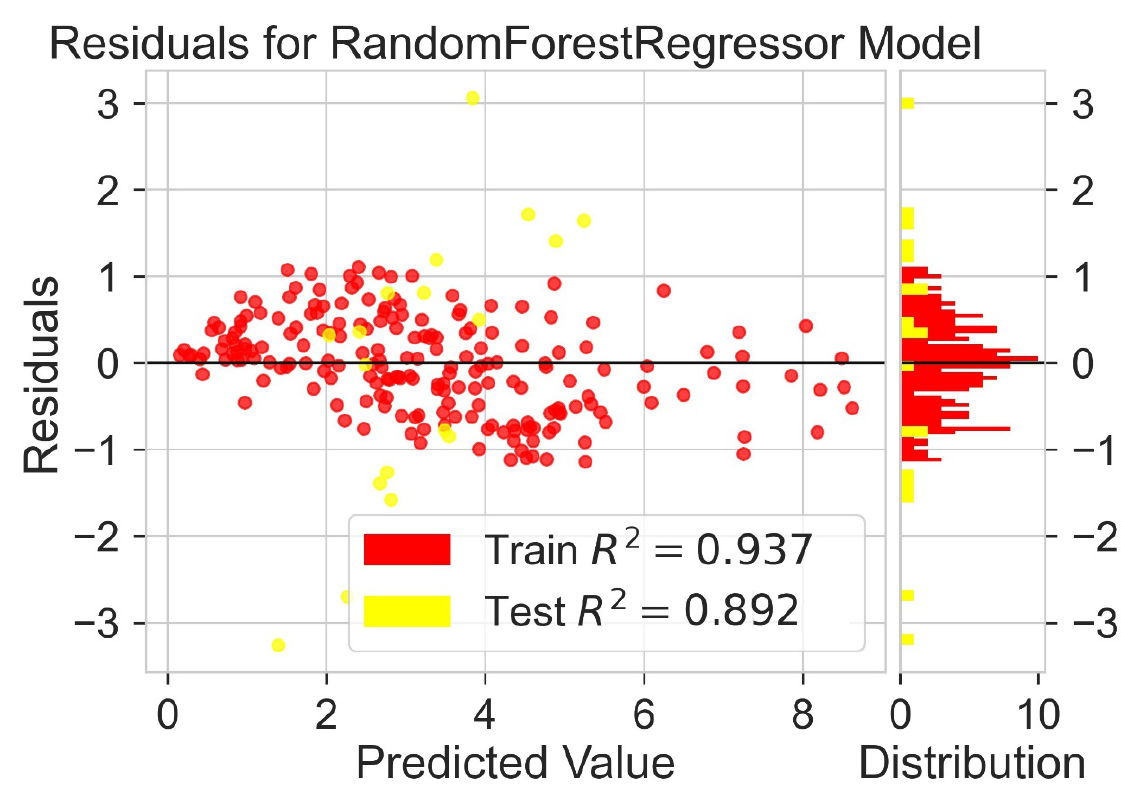
Figure 7. Residuals for random forest regressor model.